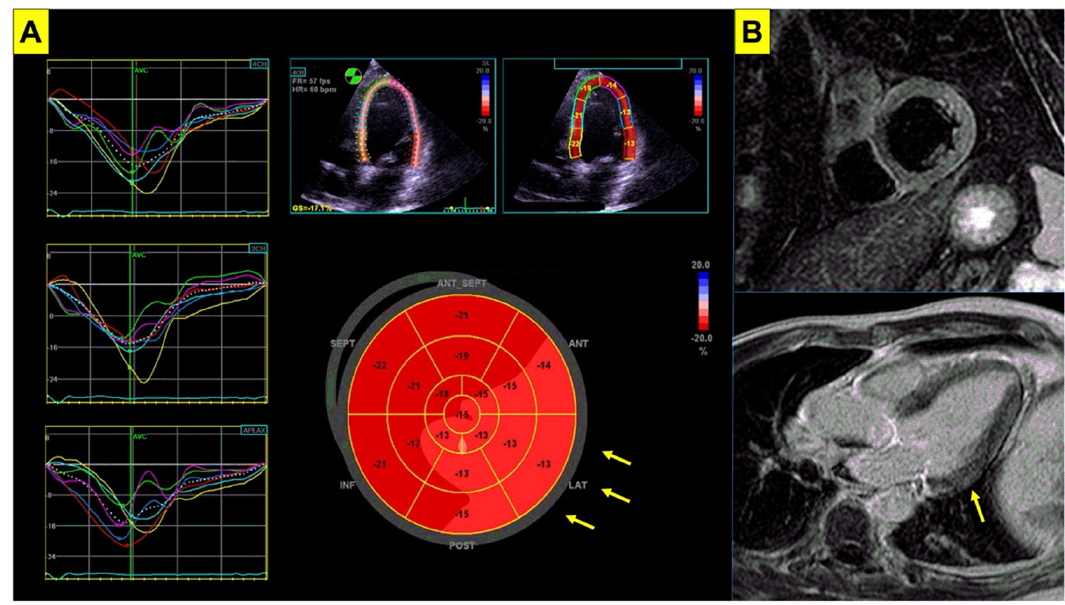
Figure 2. Imaging abnormalities in Brugada syndrome. Subtle imaging abnormalities associated with BrS are shown. Panel ( A ) echocardiogram of a patient with genetically proven BrS. Despite normal left ventricular systolic function (LVEF = 62%), impairment in global longitudinal strain is shown (GLS = − 16%, nv < − 20%) mainly involving the lateral wall (arrows). Panel ( B ) cardiac magnetic resonance in the same patient shows slight hyperintensity in T2-weighted short tau inversion recovery sequences (STIR, upper panel) involving the inferolateral basal segment of the left ventricular wall, and focal late gadolinium enhancement (LGE, lower panel) involving the basal segment of the lateral wall (arrow). BrS = Brugada syndrome; LVEF = left ventricular ejection fraction. 4. Histopathological Findings From the first characterizations of the ECG pattern, structural alterations, such as fibrosis, fibrolipomatosis, and RV cardiomyopathic changes, were described in patients with apparent idiopathic ventricular fibrillation (VF) [53]. As recently described for desmoplakin cardiomyopathy [71], cardiac inflammation might represent a “hot-phase” in BrS and lead to the natural progression of the disease [72,73]. Lymphocytic myocarditis (Figure 3) with inflammatory infiltrates and focal necrosis, with or without microaneurysms, was found in endomyocardial biopsies from the RV, and the LV as well, in patients with symptomatic BrS [56]. Among BrS patients, those who were carriers of SCN5A mutations displayed more cardiomyopathic changes. Remarkably, many patients were positive for intracardiac viral genomes. The authors suggest that the classic BrS ECG pattern is not a marker of a specific syndrome, but rather an electrical expression of RV structural abnormalities which may be the outcome of genetic, infective, and inflammatory conditions. In another study, RVOT endomyocardial biopsy, guided by a three-dimensional voltage map, showed that myocardial inflammation at histology correlated with a higher prevalence of abnormal bipolar map and greater bipolar low-voltage area extension in patients with BrS [10]. Notably, parvovirus B19 was associated with myocarditis-induced VF in many patients with BrS [57–59]. On the other hand, critical SCN5A variants can be found in patients with arrhythmic myocarditis, even in the absence of the BrS ECG pattern [74]. These findings support the role of myocardial inflammation as a possible arrhythmogenic substrate [75,76].